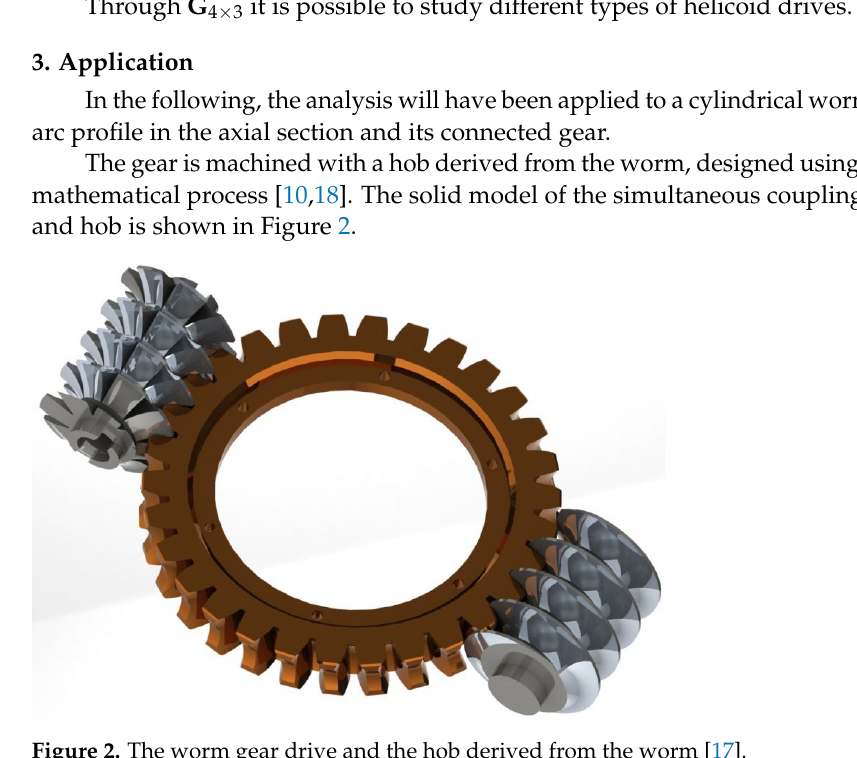
Figure 2. The worm gear drive and the hob derived from the worm [17]. The geometrical parameters of the worm profile, such as the radius of the circle arc ρ ax , the distance between the worm axis and the center of the profile circle K are shown in Figure 3.